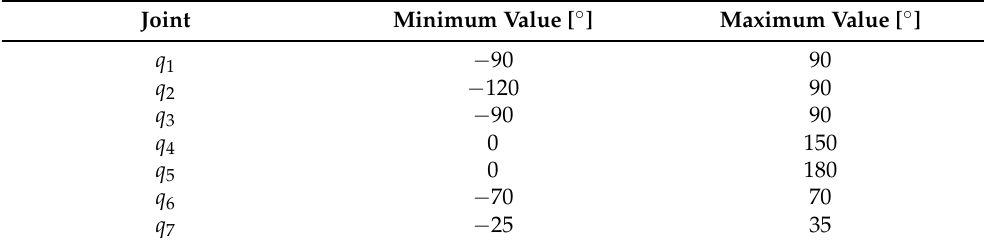
Figure 2. Kinematic models of the human arm ( a ) and the UR5e ( b ) implemented in Matlab Robotic Toolbox. Table 1. Joint limits of the human arm.